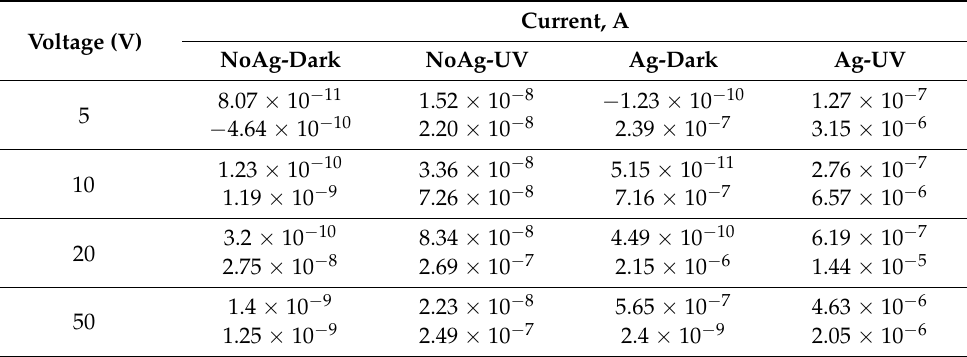
Table 2. Current comparison of different applied voltages compared to the photocurrent and dark current of Ga 2 O 3 on quartz with and without the presence of the silver